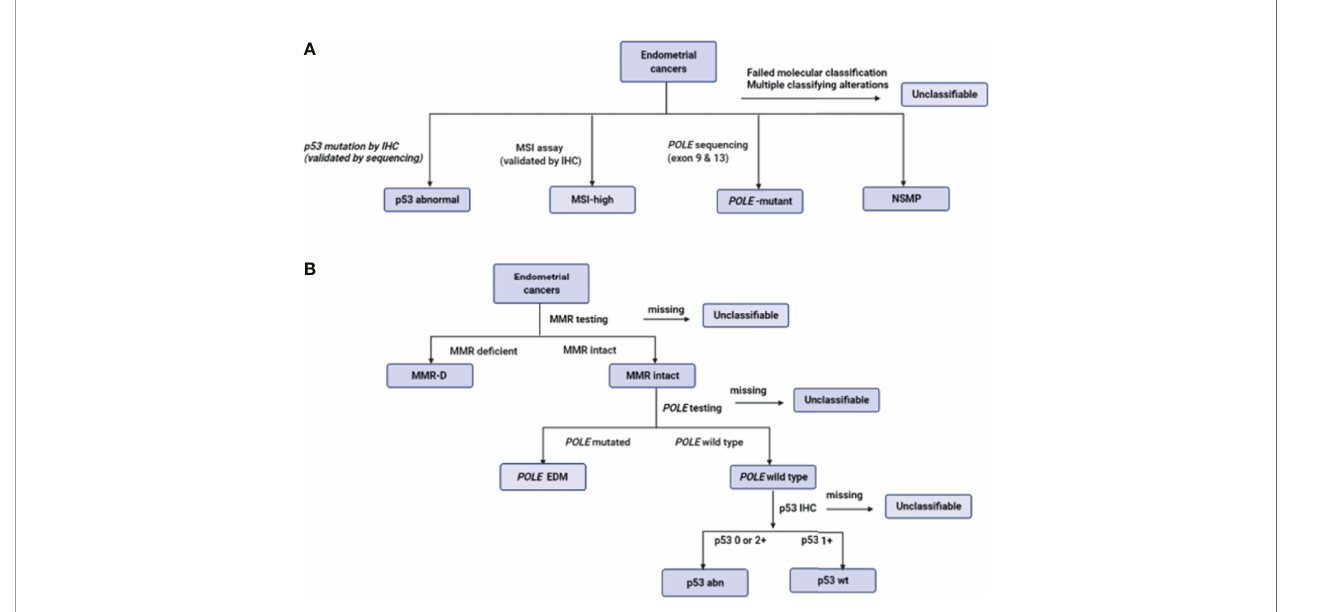
FIGURE 2 | De fi ning the molecular subgroups of endometrial cancer based on the TransPORTEC classi fi er (A) and ProMisE (B) . Adapted from (48, 49,